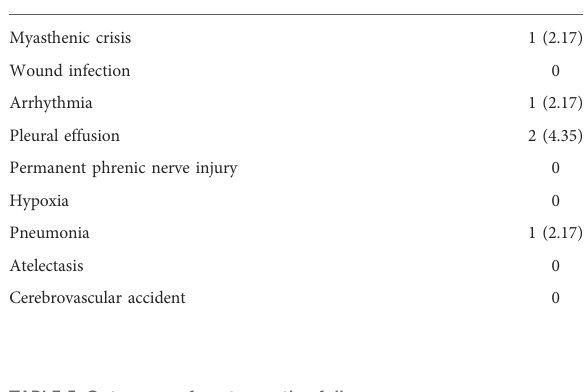
TABLE 5 Outcomes of postoperative